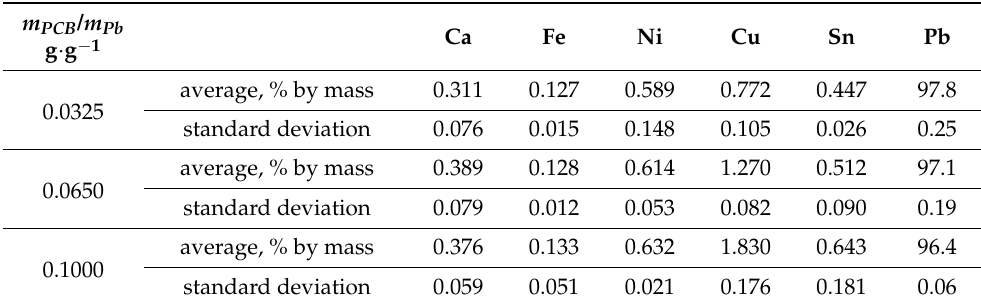
Table 4. Chemical compositions of the lead ingots after melting with PCB pyrolyzate “B1”, averages and standard deviation of 3 analyses.